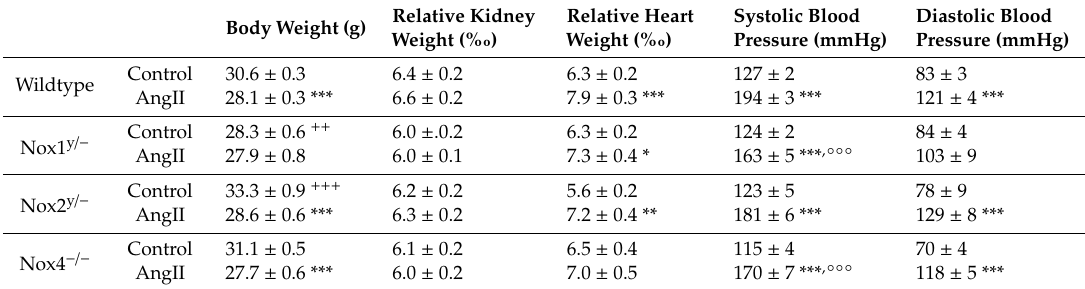
Table 1. Blood pressure, body weight, and body weight ratios of the animals.